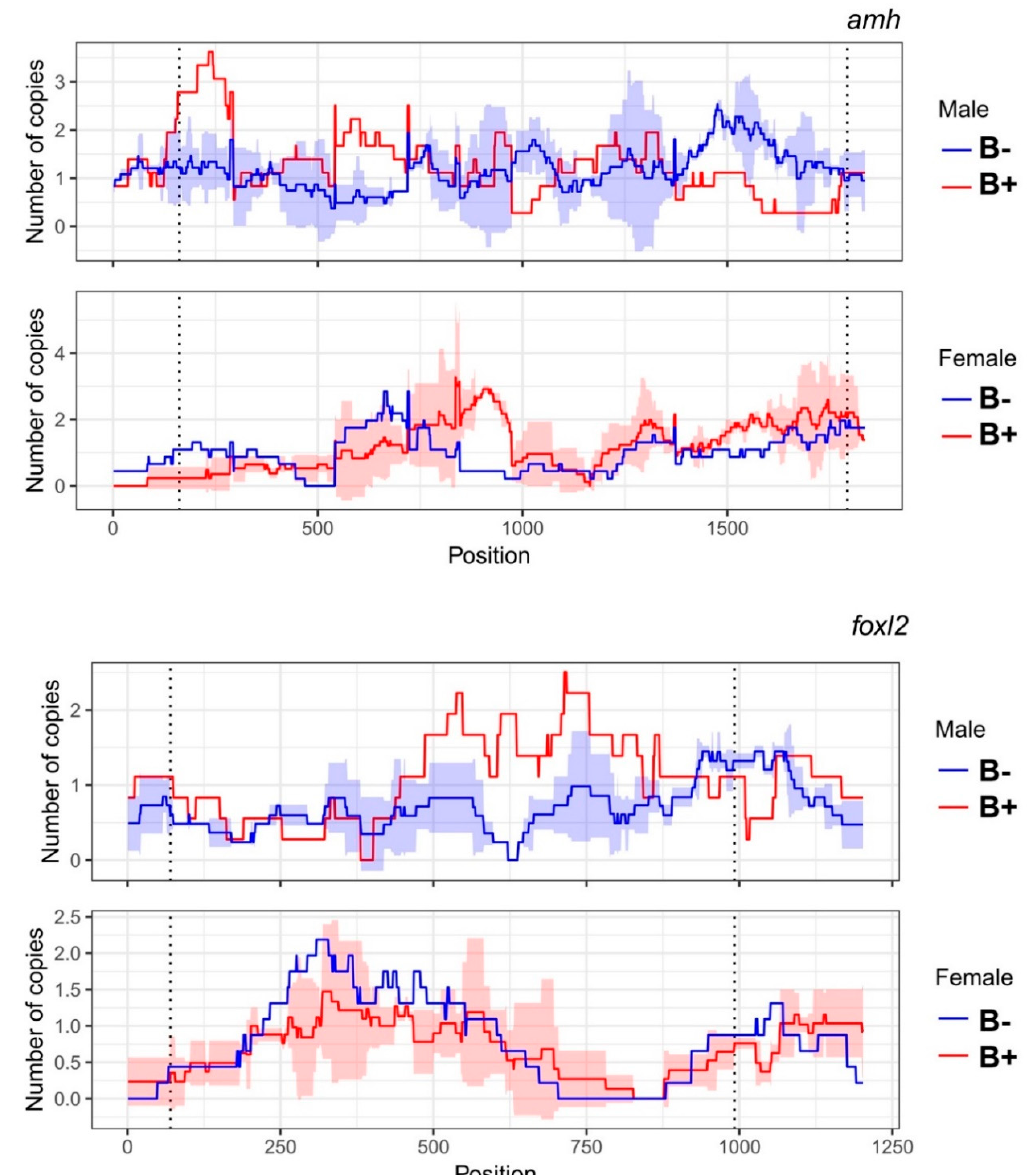
Figure 3. Comparison of the number of copies of the amh and foxl2a genes in gDNA of individuals with (B + ) and without the B chromosome (B − ). The dotted line is the limit of the coding sequence (CDS). The p -value ( p < 0.05) between copy number was not significantly di ff erent ( p = 0.8509 and 0.7333 for the t -test of male and female amh , respectively, and p = 0.2979 and 0.7752 for the t -test of male and female foxl2a, respectively).